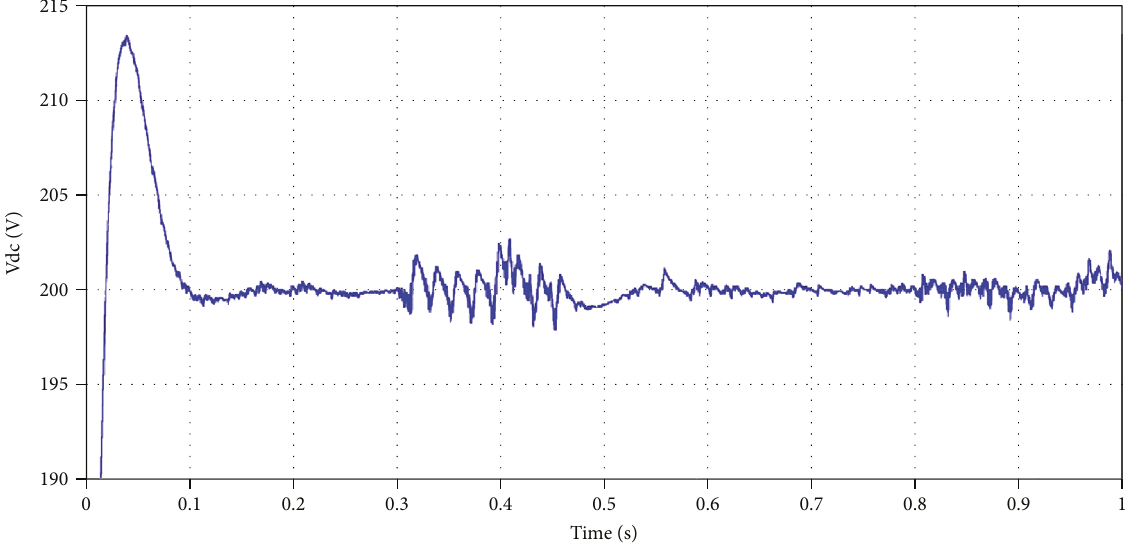
Figure 17: Capacitor voltage control in the STATCOM device with a PI λ -MPC hybrid